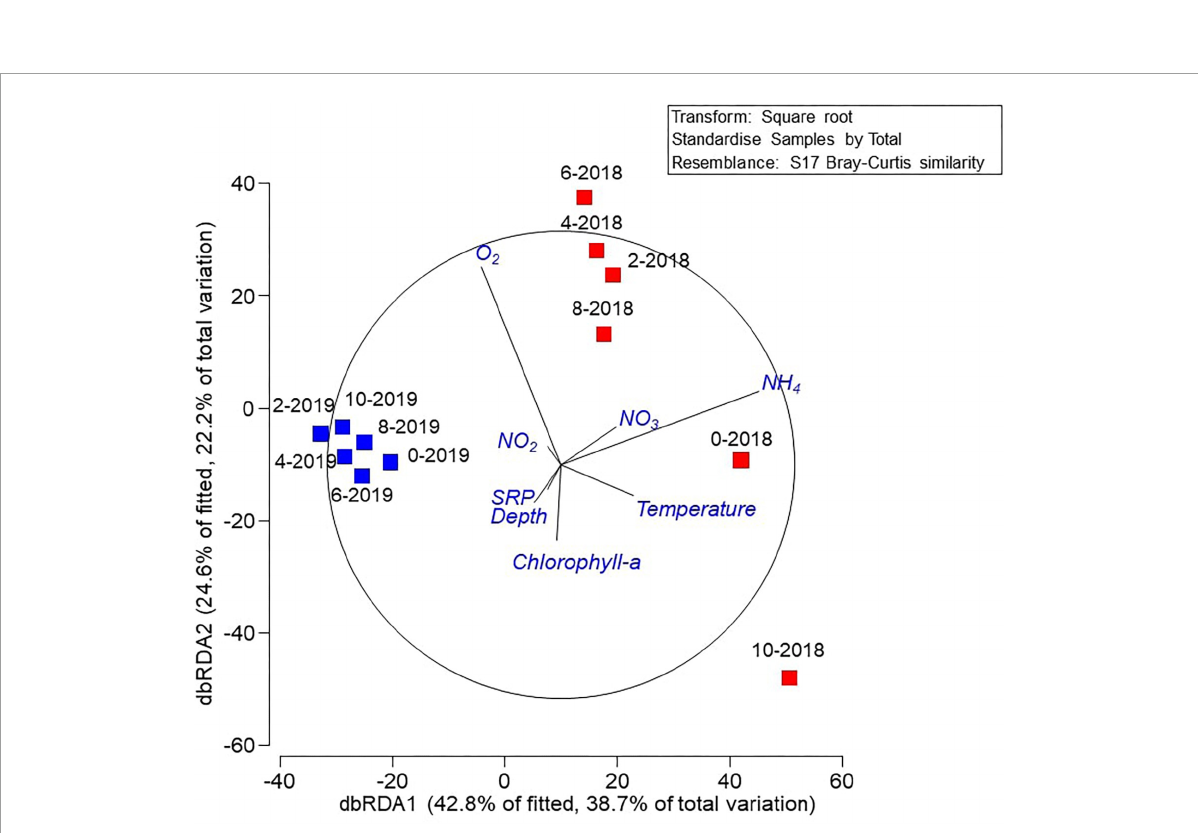
FIGURE4 Distance-based redundancy analysis (dbRDA) plot of the DistLM based on geochemical parameters fitted to the variation in ASV abundance. Vectors indicate direction of the parameter effect in the ordination